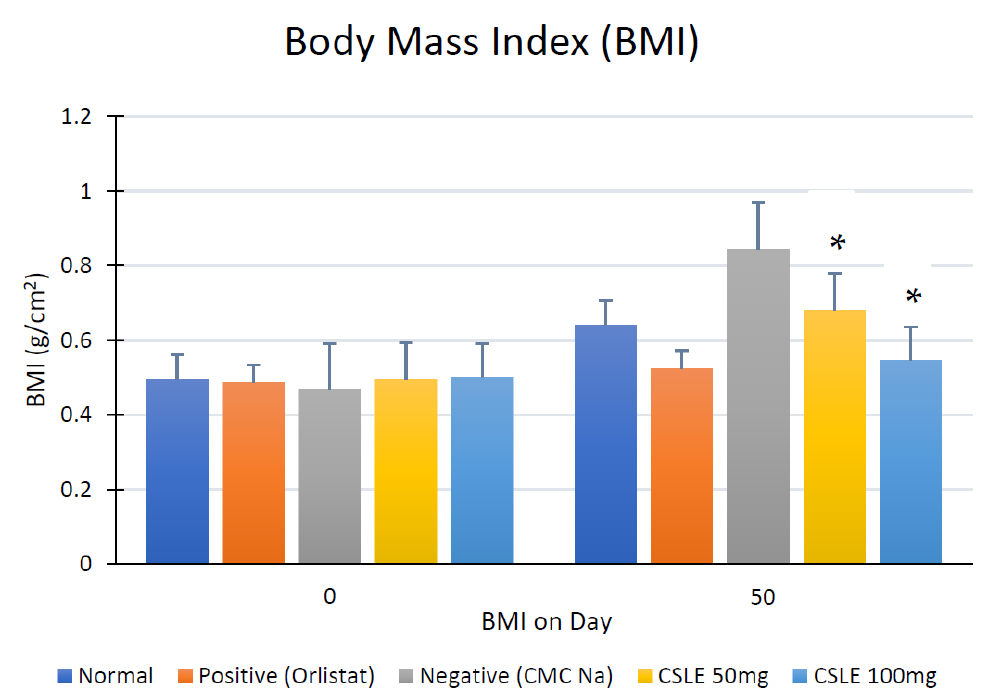
Figure 2. Animal body mass index (BMI) was compared between day 0 and day 50. * p < 0.05.